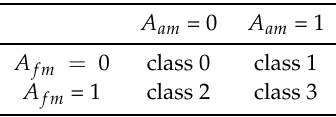
Table 1. Overview of